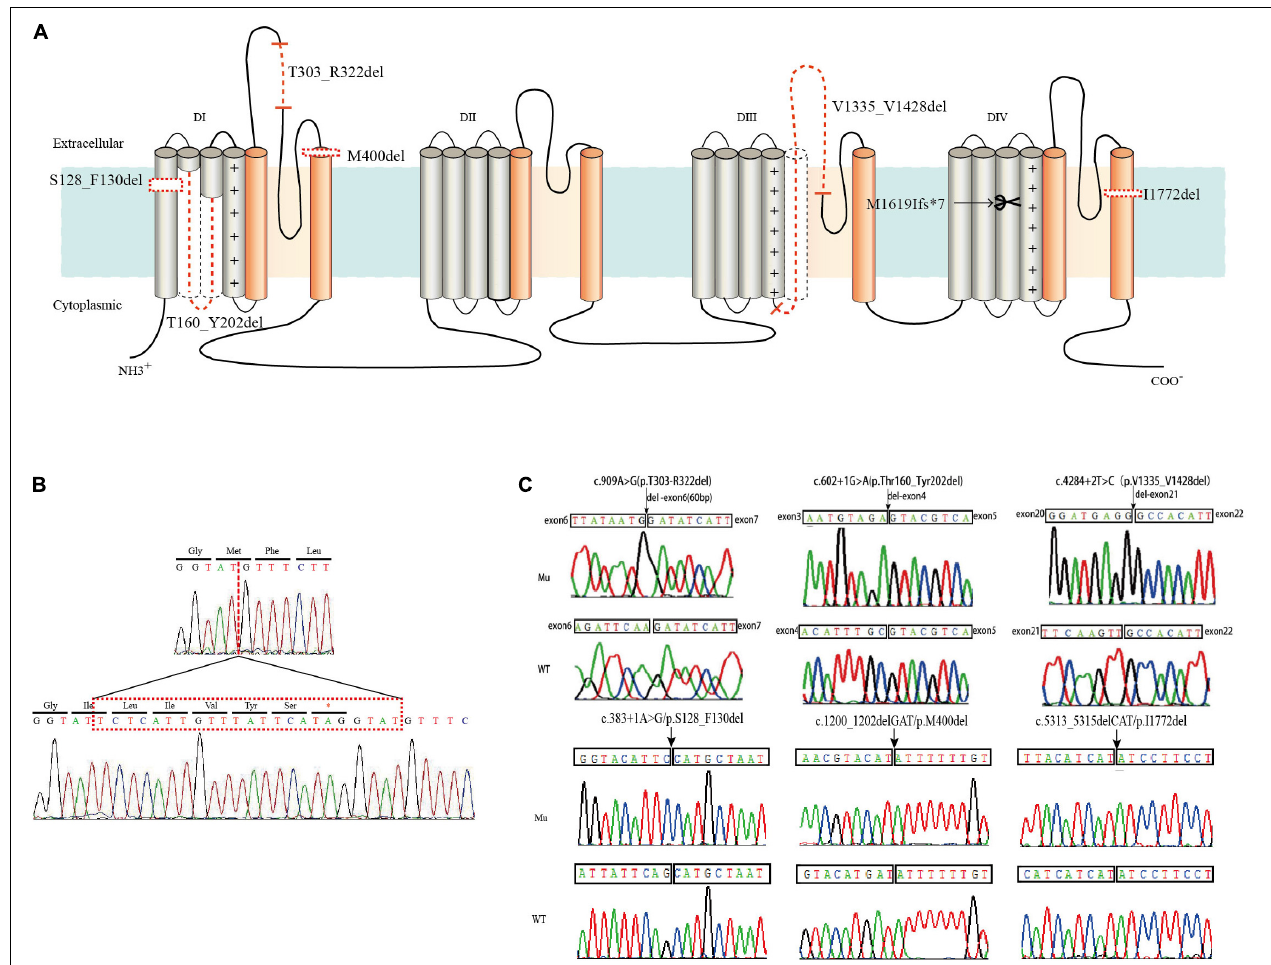
FIGURE 1 | Locations of six in-frame deletion and one truncating variants in SCN1A and sequence identification. (A) Schematic location of the variants identified. The in-frame deletion variants were marked with dotted lines and the truncating variant was marked with a scissor. (B) DNA sequencing of the truncating variant (c.4853-25T > A/p.M1619Ifs ∗ 7). (C) DNA sequencing of the in-frame deletion